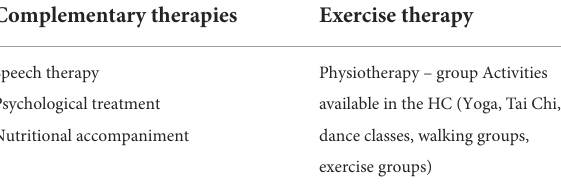
TABLE 4 Complementary and exercise therapy for people with